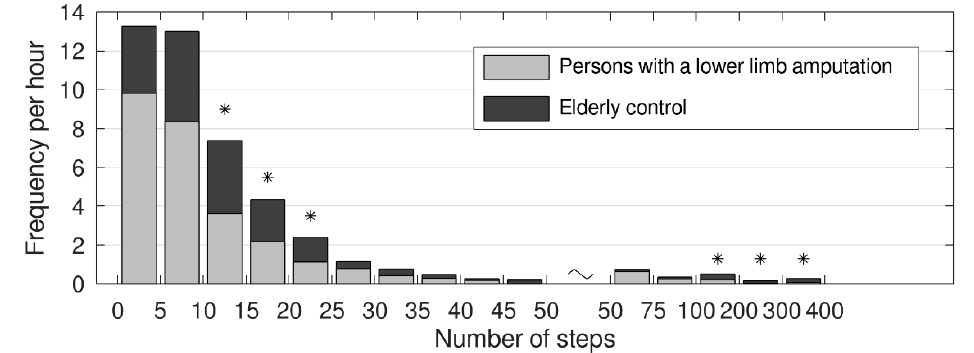
Figure 2. The mean frequency per hour of the number of steps per bin. Grey bars are persons with a lower limb amputation, black bars are the elderly controls. * Post-hoc difference between the persons with a lower limb amputation and the elderly control group.